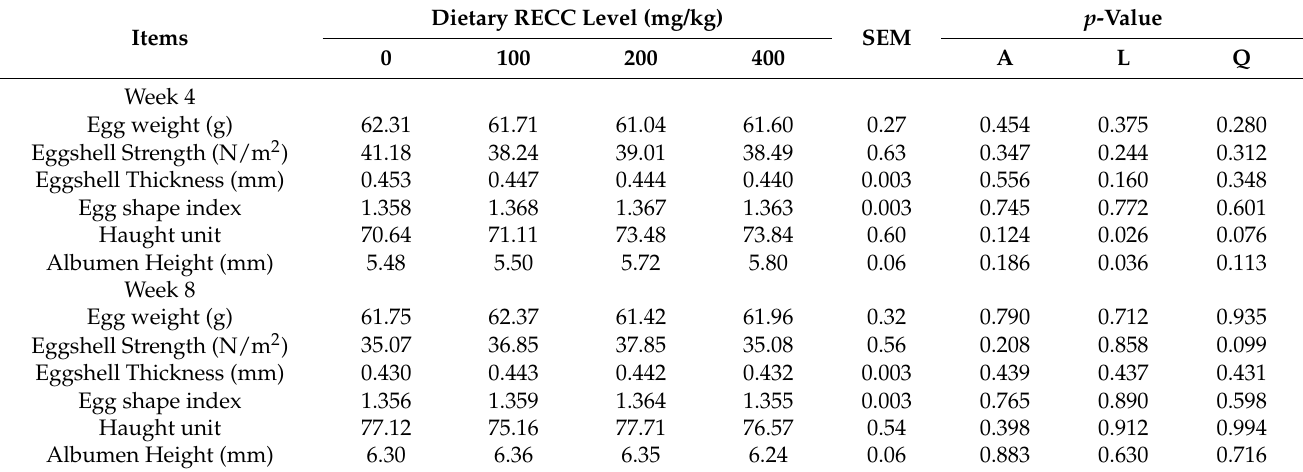
Table 3. Effects of dietary rare earth chitosan chelates (RECC) on egg quality of laying